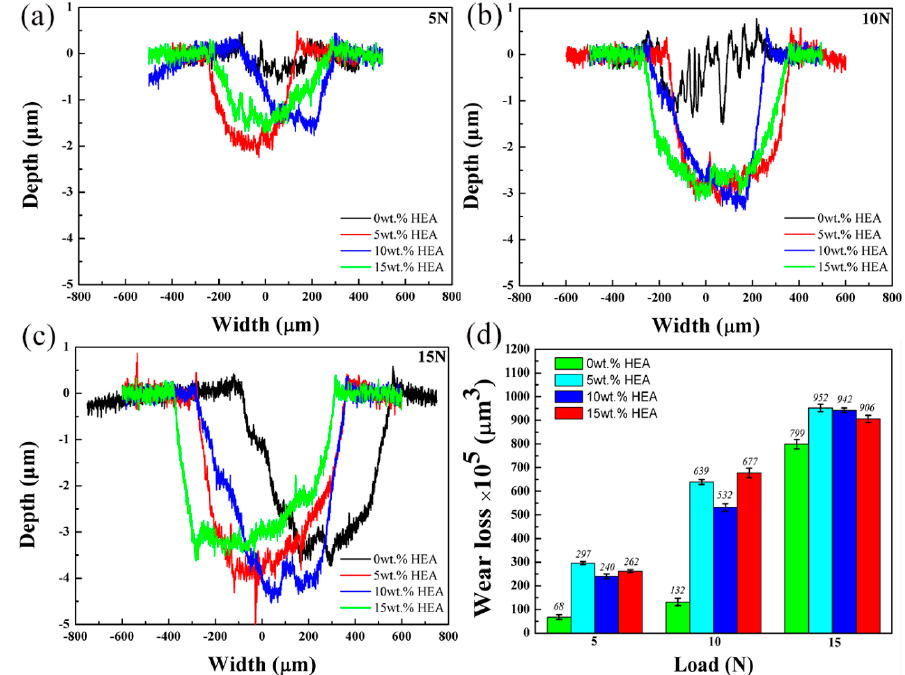
Figure 10. Cross-section profiles and wear losses of the worn plates: ( a ) 5N cross section profiles; ( b ) 10N cross section profiles; ( c ) 15N cross section profiles; and ( d ) wear losses.